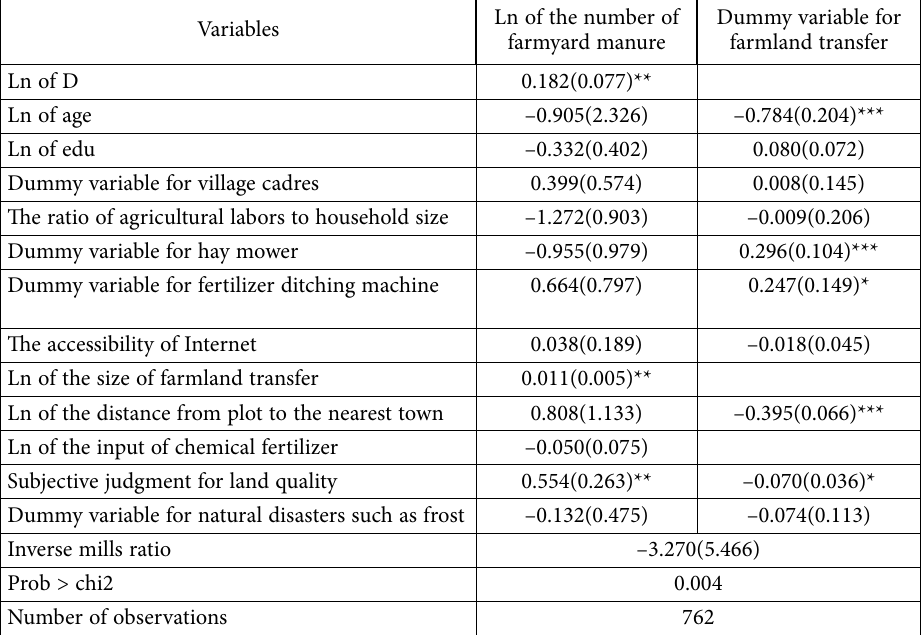
Table 8. Estimation results of the Heckman two-stage regression